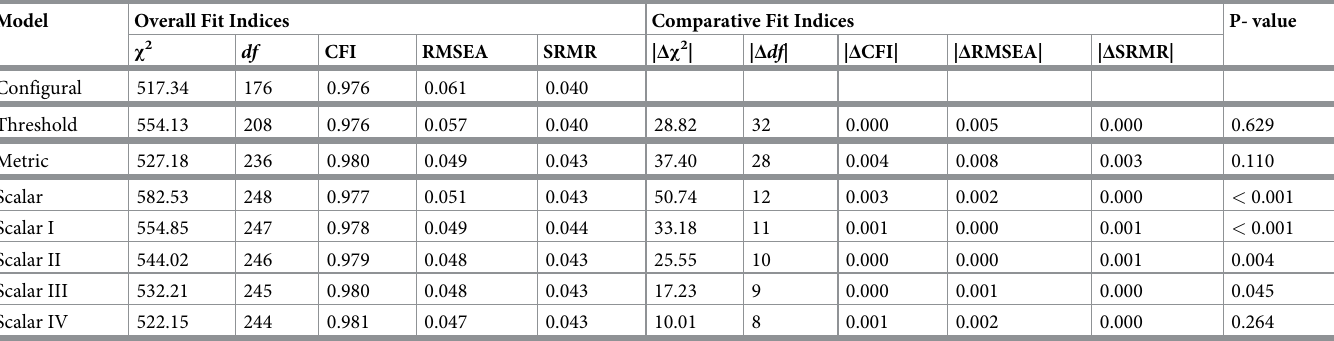
Table 1. Fit indices for multigroup confirmatory factor analyses of items on the connection to nature index.